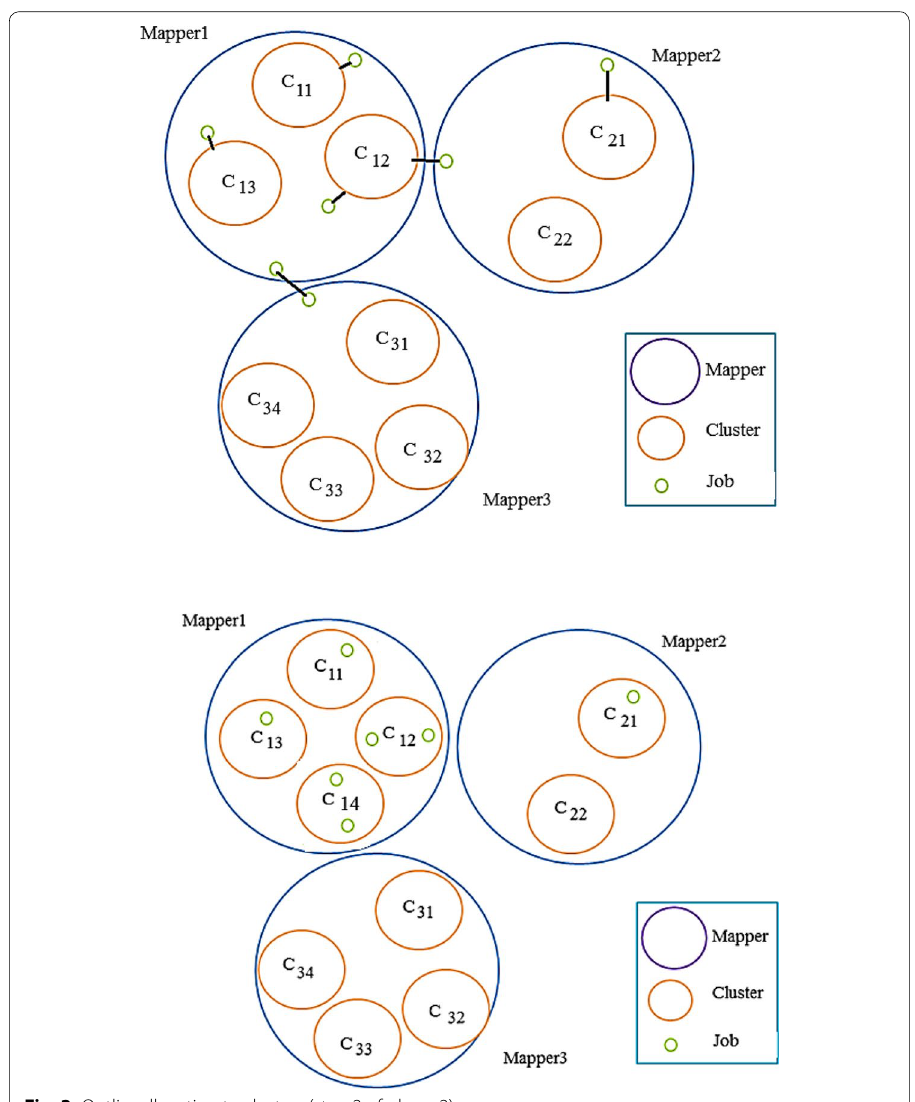
Fig. 3 Outlier allocation to clusters (step 2 of phase